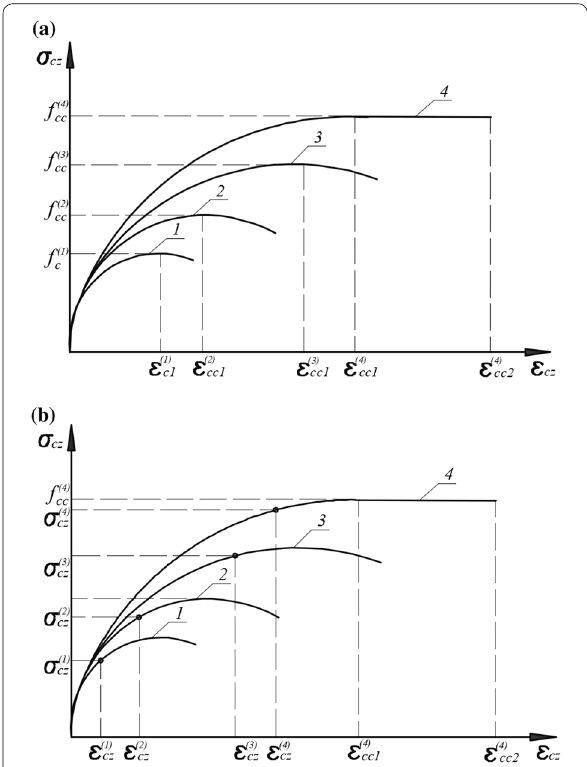
Fig. 3 The family of concrete deformation diagrams with a step-by-step increase of axial deformations: a the coordinates of diagram vertices, b to the determination of stresses with relative deformation increase; 1—uniaxial compression, 2, 3—volumetric compression at intermediate stages of deformation, 4—volumetric compression in the limiting